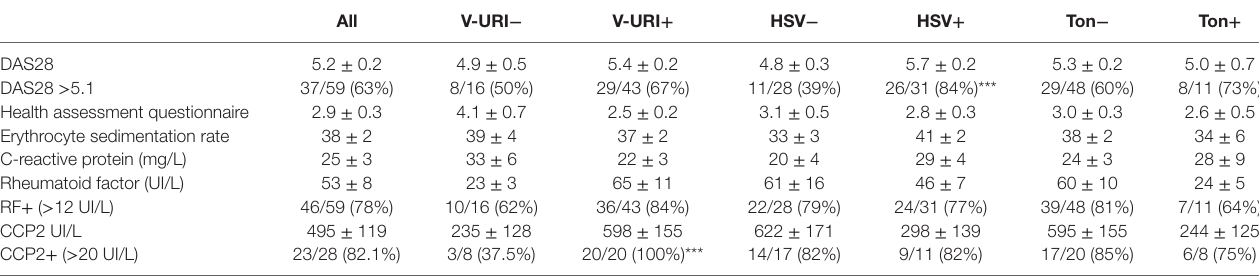
Table 2 | Characteristics of early (e)RA patients according their infection symptoms reported in the previous year: all studied infection symptoms (All), viral upper respiratory tract infection symptoms (V-URI), Herpes simplex virus (HSV) exacerbation or reactivation, and chronic tonsillitis (Ton) exacerbation.